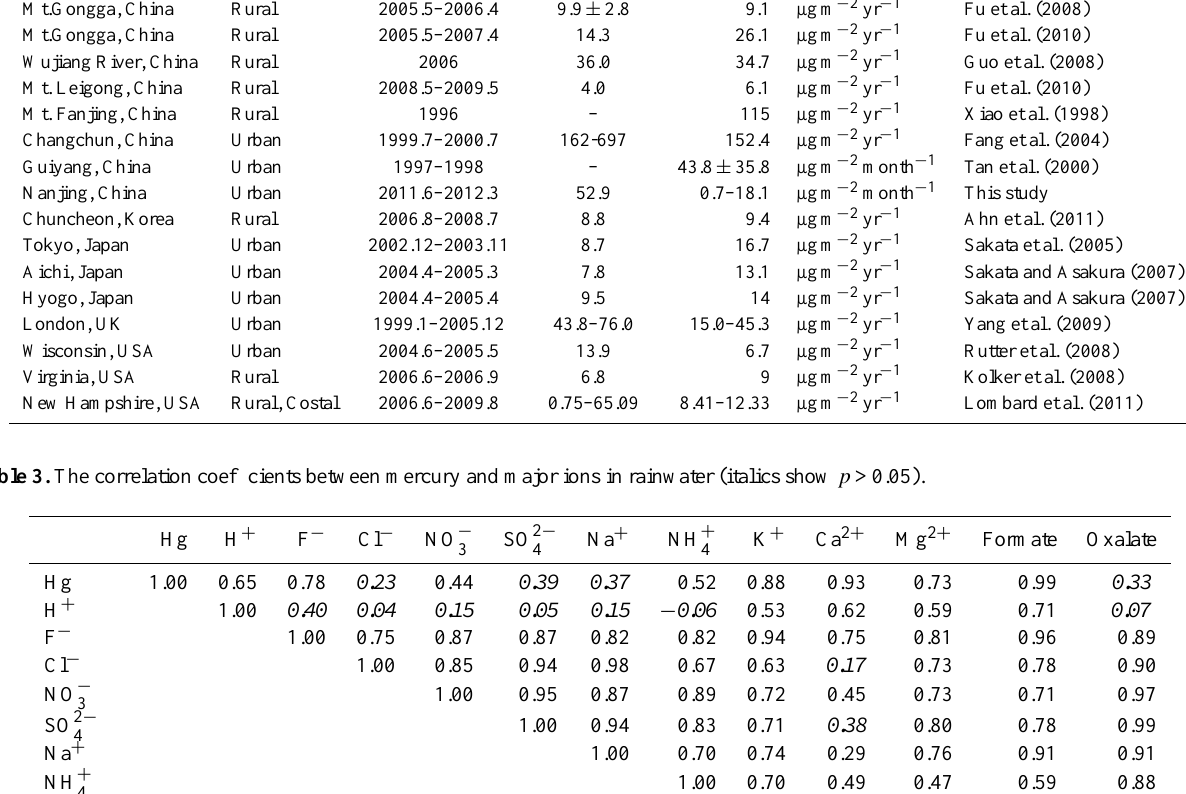
Table 2. Summary of wet deposition of mercury in China and other countries. Locations